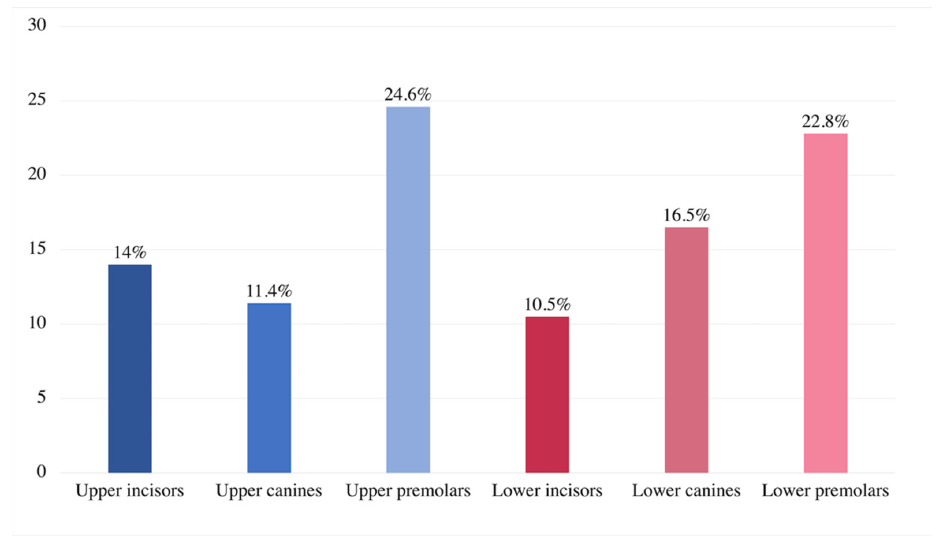
Figure 6. Distribution of pre-treatment gingival recessions in different groups of teeth. The median GR improvement was 0.55 mm (Q1, Q3: 0.12, 0.96) ( p = 0.001), with 58.7%